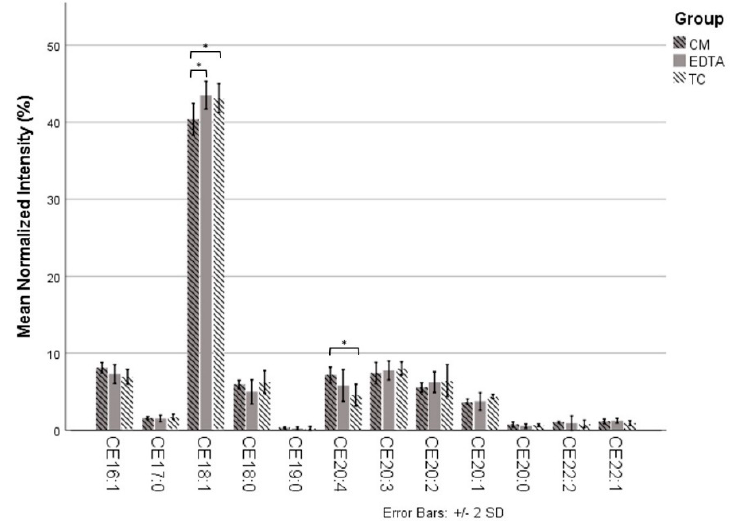
Figure 3 . Comparison between the three harvesting techniques for the relative abundance of the cholesteryl esters (CEs) that were common ( n c < 24) to both cell and media samples. There were no differences between the three techniques for 10 of the 12 CEs. The chloroform–methanol (CM) method yielded less CE18:1 than the EDTA and trypsin-containing (TC) methods but greater CE20:4 than the TC method. * p < 0.05, chloroform–methanol (CM), ethylenediaminetetraacetic acid (EDTA), trypsin-containing (TC) (trypsin–EDTA).